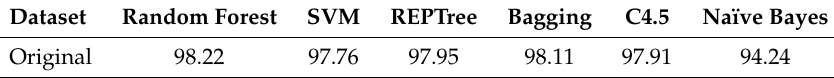
Table 1. Classification accuracy (%) for the original WUIL